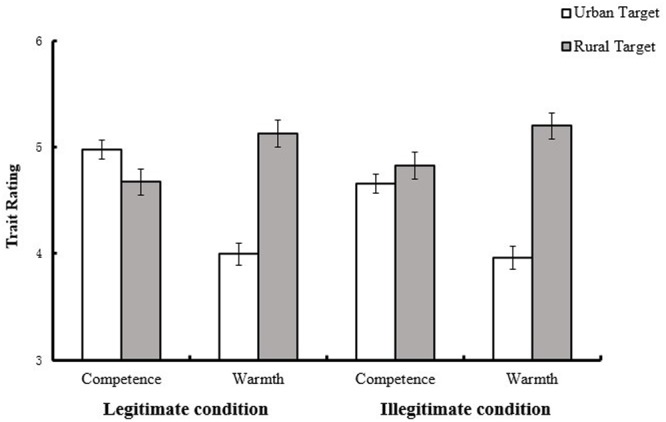
Participants’ ratings of urban and rural groups in different conditions (Study 3). Error bars represent standard error of means.